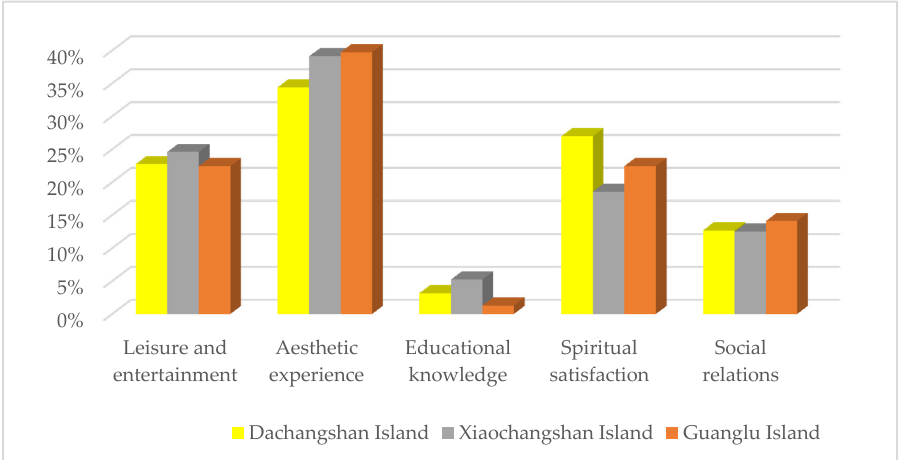
Figure 5. Comparison of the proportions of multiple recreational and cultural services values on the three main islands.